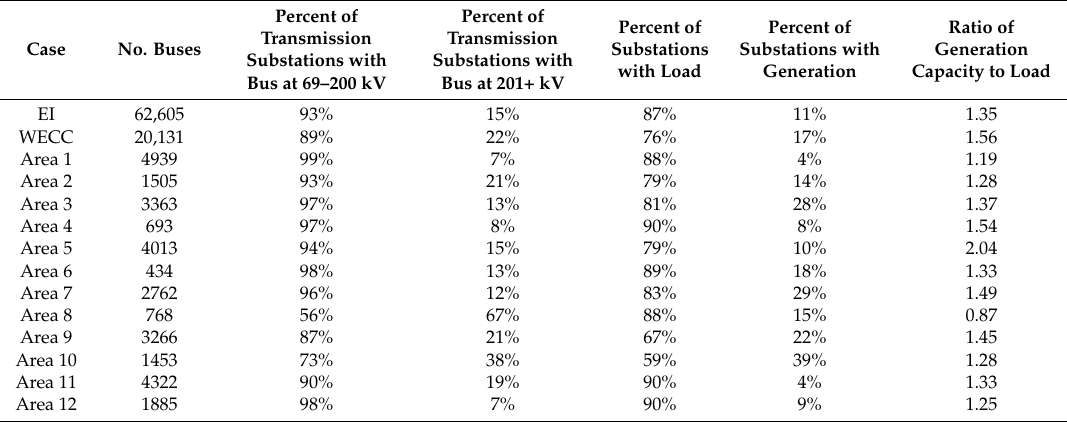
Table 1. Statistics on case substations: voltage levels, load, and